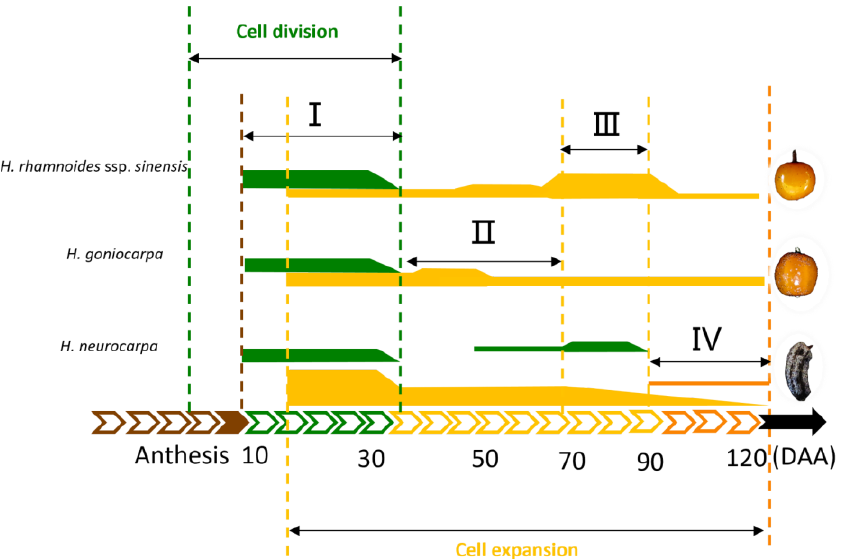
Figure 10. Cellular scenario for three species of Hippophae fruit development. Green lines represent cell division, yellow lines represent cell expansion. The different line widths represent the strength of cell division or expansion. I. Cell proliferation; II. Slow growth stage (or fruit hard core stage); III. Rapid growth stage; IV. Fruit ripening.